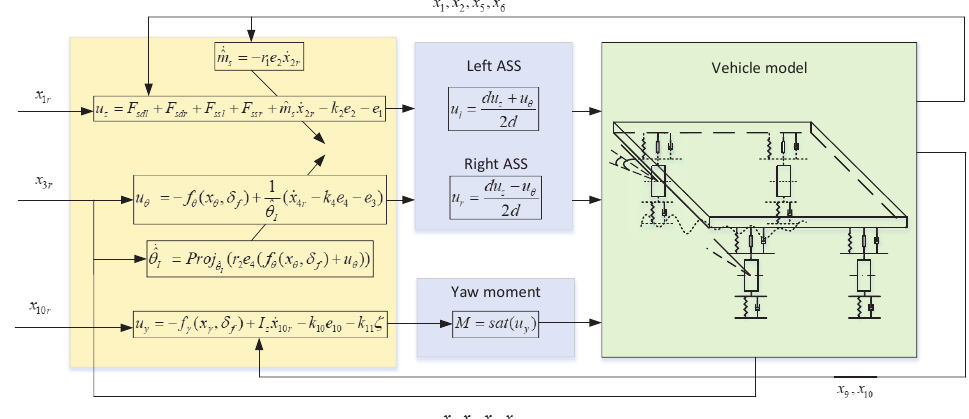
Figure 2. Control scheme